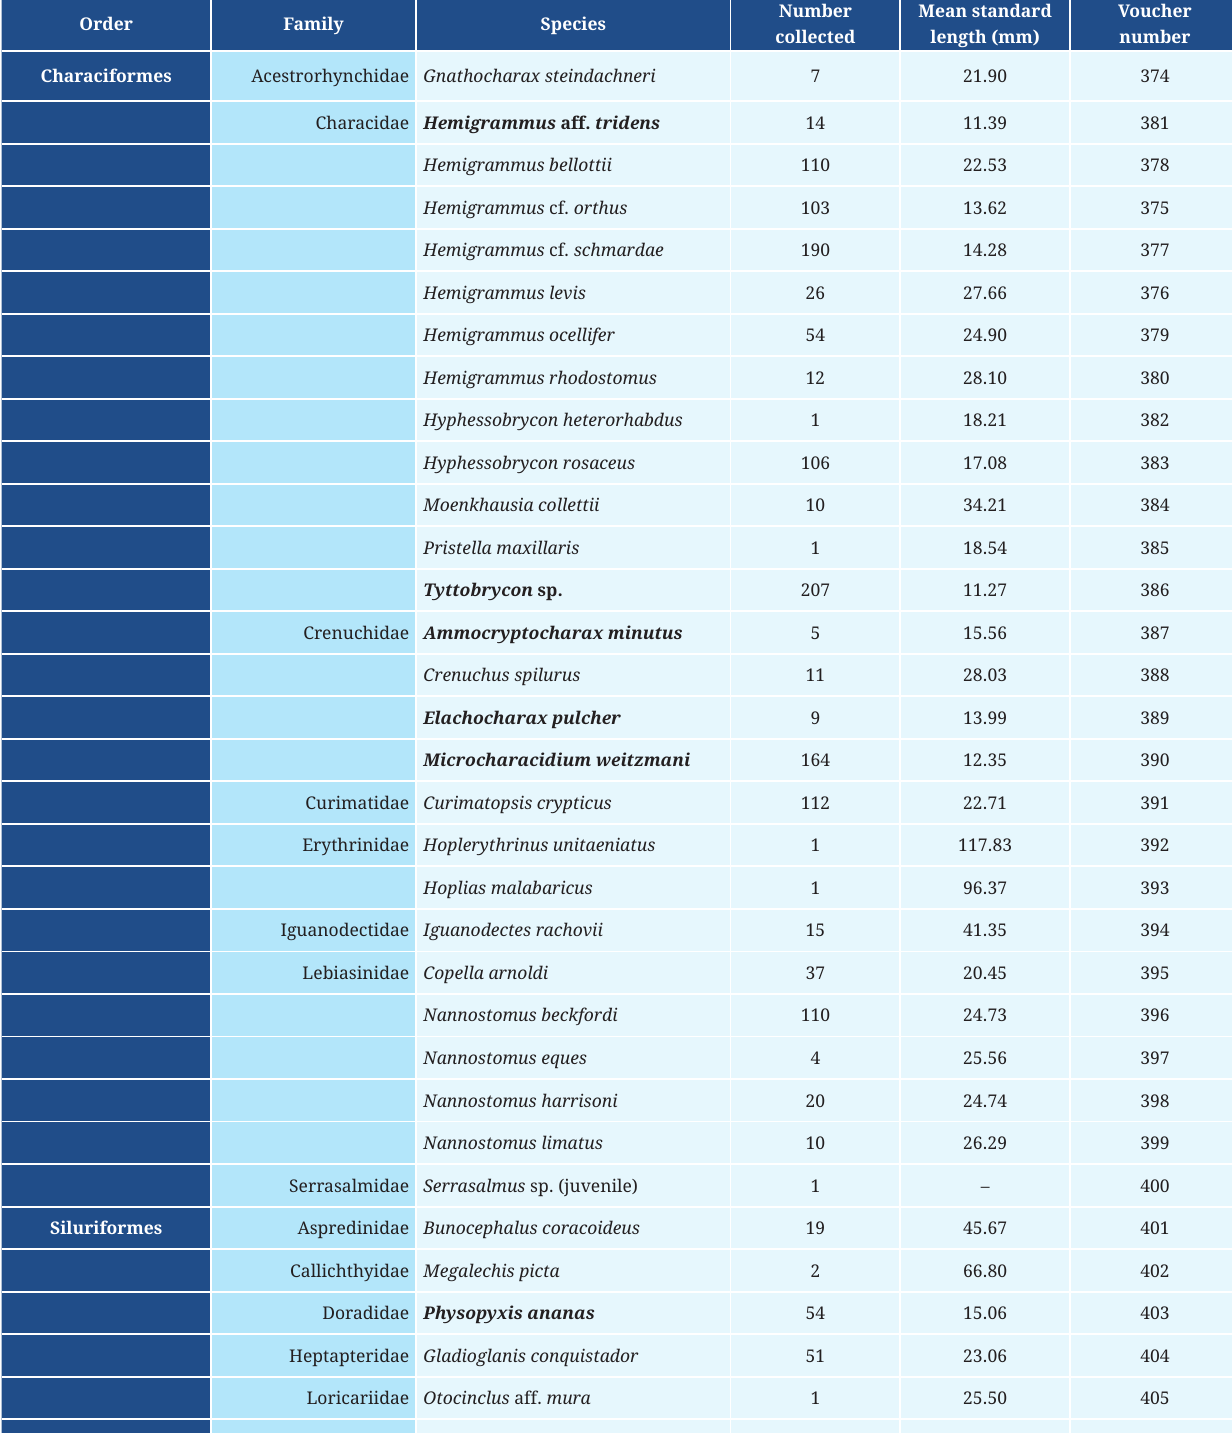
TABLE 1 | Fishes collected from the rio Jacundá in the Amazon basin, Brazil, during August 2019, including the number of specimens collected and mean standard length of specimens. Miniature fishes are shown in bold text. Lengths were not recorded for two juvenile non-miniature specimens (“–“). Vouchers are deposited at Laboratório de Ictiologia de Sorocaba